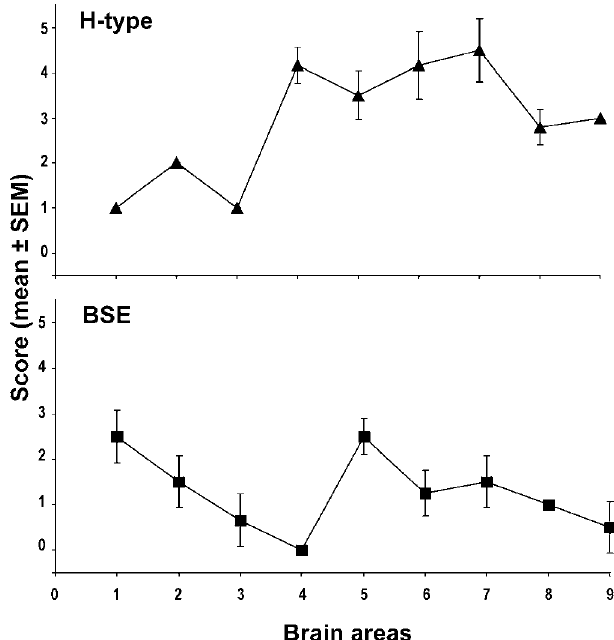
Figure 4. Lesion Profiles in tgBov Mice Infected with H-Type or BSE Agents Mean scores ( 6 SEM) reflecting the intensity of vacuolation are shown for H-type (no. 1 and no. 3, triangles) and BSE (no. 1 and no. 3, squares). The nine grey-matter areas used to construct the profile are as follows: dorsal medulla (1); cerebellar cortex (2); superior colliculus (3); hypothalamus (4); medial thalamus (5); hippocampus (6); septum (7); medial cerebral cortex at the level of the thalamus (8); and medial cerebral cortex at the level of the septum (9). DOI: 10.1371/journal.ppat.0020112.g004